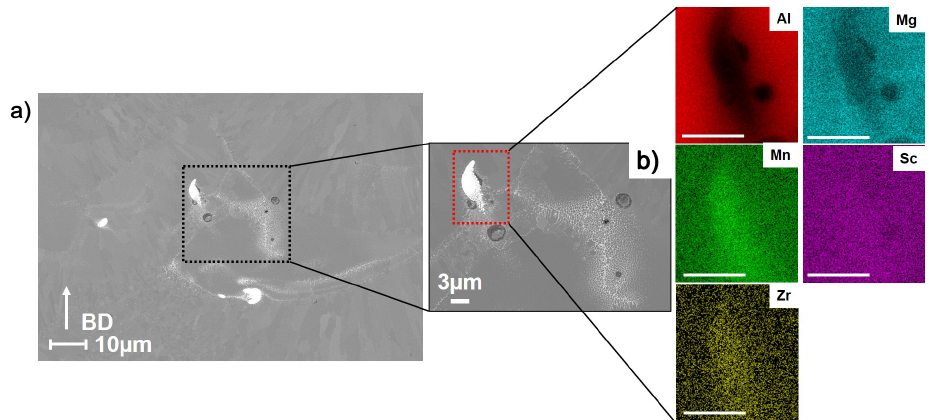
Figure 10. ( a ) Electron microscopy images for peak-aged condition (598 K for 4 h). Very few such precipitates are seen in the sample ( b ) Inset image shows a magnified section where such precipitate is shown. The EDX maps at the region show Al, Mg, Mn, and Zr as identified elements. It is seen that these precipitates contain Mn and Zr. These could have formed from LB-PBF processing as primary precipitates from melt and may also be present in as-printed samples. The scale bar for EDX images represents 5 µm